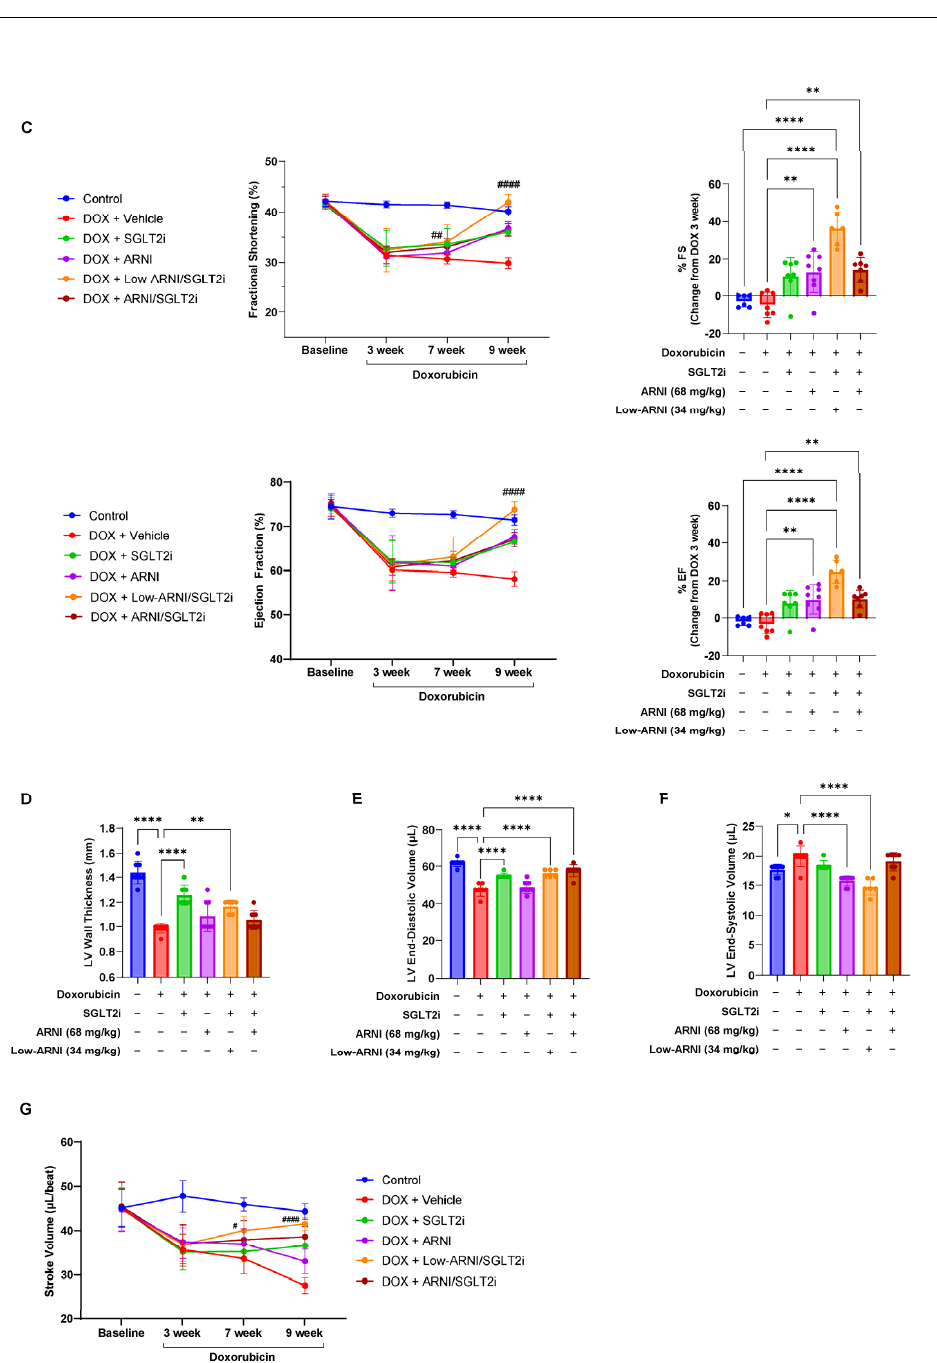
Figure 2. Recovery effects of Low-ARNI/SGLT2i treatment on doxorubicin-induced cardiac dys- function. ( A ) Schema of chronic heart failure model (15 mg/kg total). ( B ) Representative M-mode echocardiography images after 9 weeks in indicated experimental groups. ( C ) Fractional shorten- ing (FS%) and ejection fraction (EF%) at baseline and 3, 7, and 9 weeks after doxorubicin injection. ( D ) LV wall thickness. ( E ) LV end-diastolic volume. ( F ) LV end-systolic volume 9 weeks after dox- orubicin injection. ( G ) Stroke volume at baseline and 3, 7, and 9 weeks after doxorubicin injection ( n = 6–8/group). # p < 0.05, ## p < 0.01, #### p < 0.0001 compared to doxorubicin + vehicle group. * p < 0.05, ** p < 0.01, **** p < 0.0001. At baseline, there was no difference in LV end-diastolic volume (LVEDV), LV end- systolic volume (LVESV), and stroke volume in the control and experimental groups. After doxorubicin injection, stroke volume significantly declined compared with that in the control group (control: 44.3 ± 1.7 µ L vs. doxorubicin + vehicle: 27.6 ± 1.8 µ L, p <